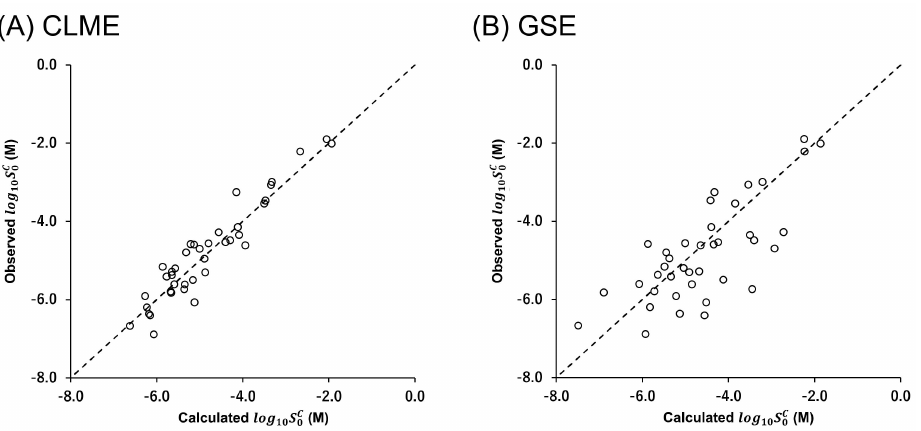
Figure 4. Correlation between the calculated and observed S C (CLME with S LLPS and T m ) and ( B ) Equation (1) (GSE using P oct ). The black dotted line indicates the 0 calculated value equals the observed value.